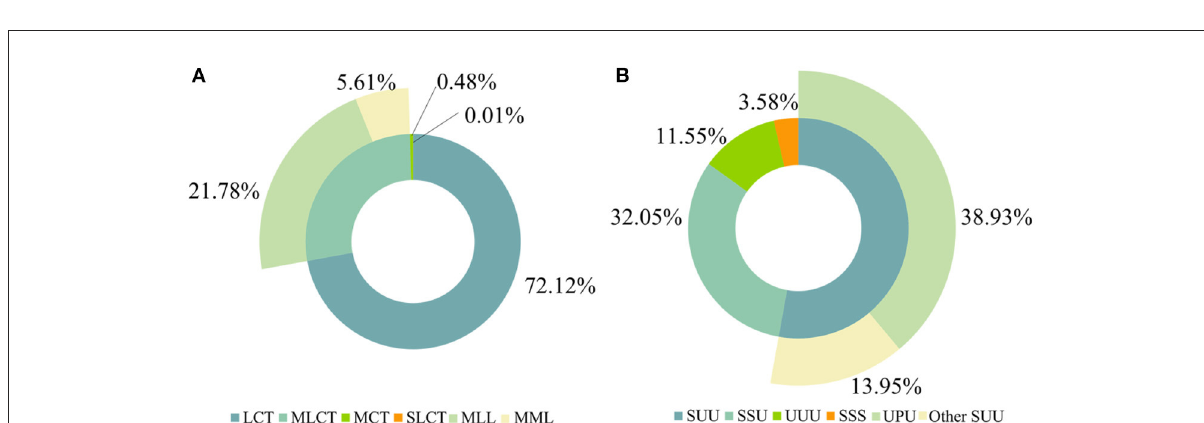
FIGURE1 Composition characteristics of TAGs in human milk based on fatty acid chain length (A) and fatty acid saturation (B) . S, short-chain fatty acids; M, medium-chain fatty acids; L, long-chain fatty acids; S, saturated fatty acids; U, unsaturated fatty acids; P, 16:0.